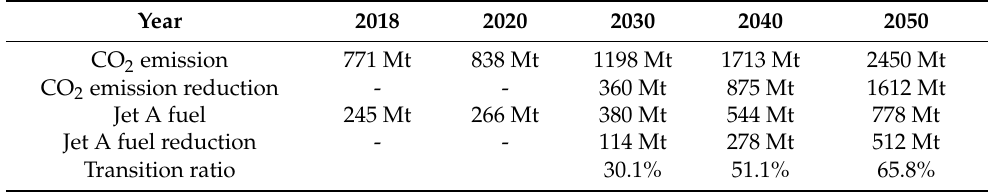
Table 3. CO 2 and Jet A fuel reduction.